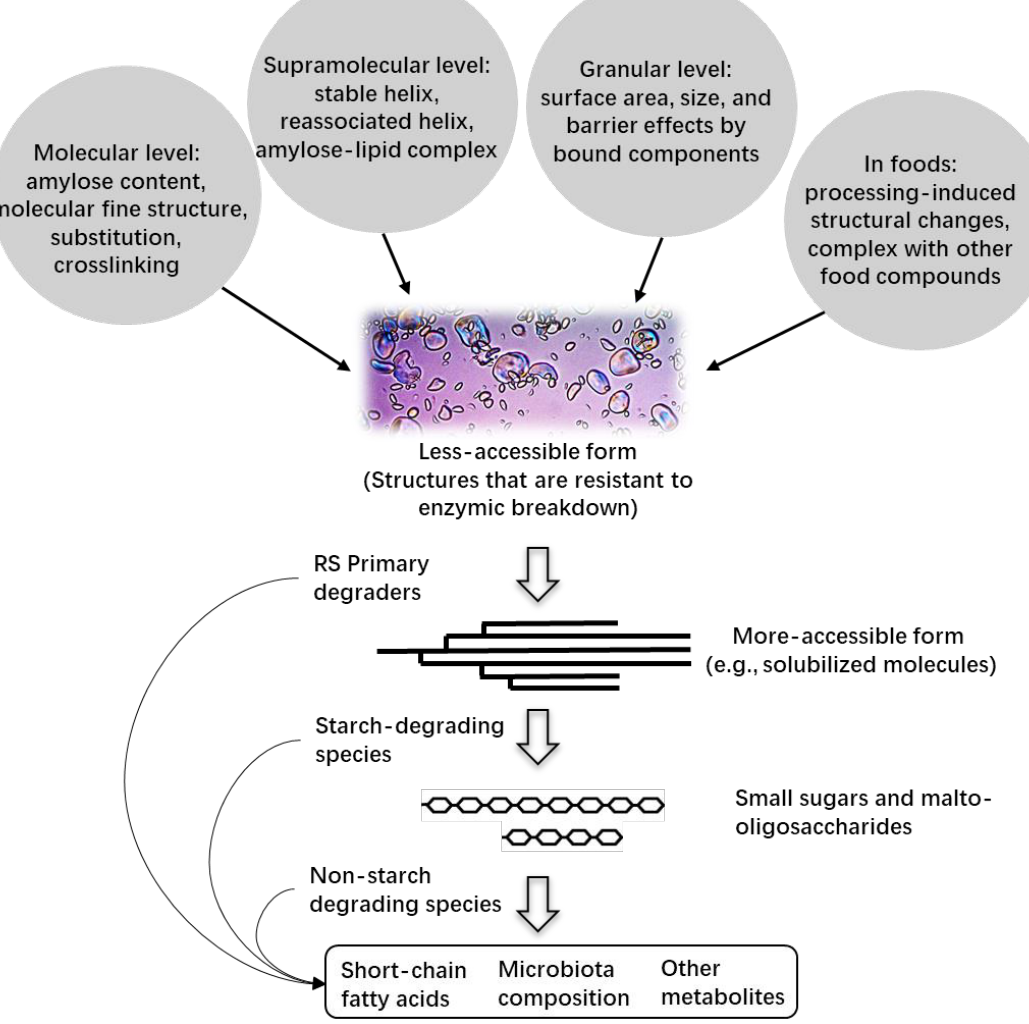
Figure 1. Schematic illustration of high-amylose starch (a type of resistant starch) fermented by the colonic microbiota. Primary degraders break down resistant starch (RS), releasing soluble starch molecules that can be used by starch-degrading species. This process may also increase the surface area of RS granules, allowing other starch-degrading species to access and utilize this energy source. Smaller sugars and malto-oligosaccharides released during the processes could support the growth of non-starch degrading species. The figure was adapted from [63].